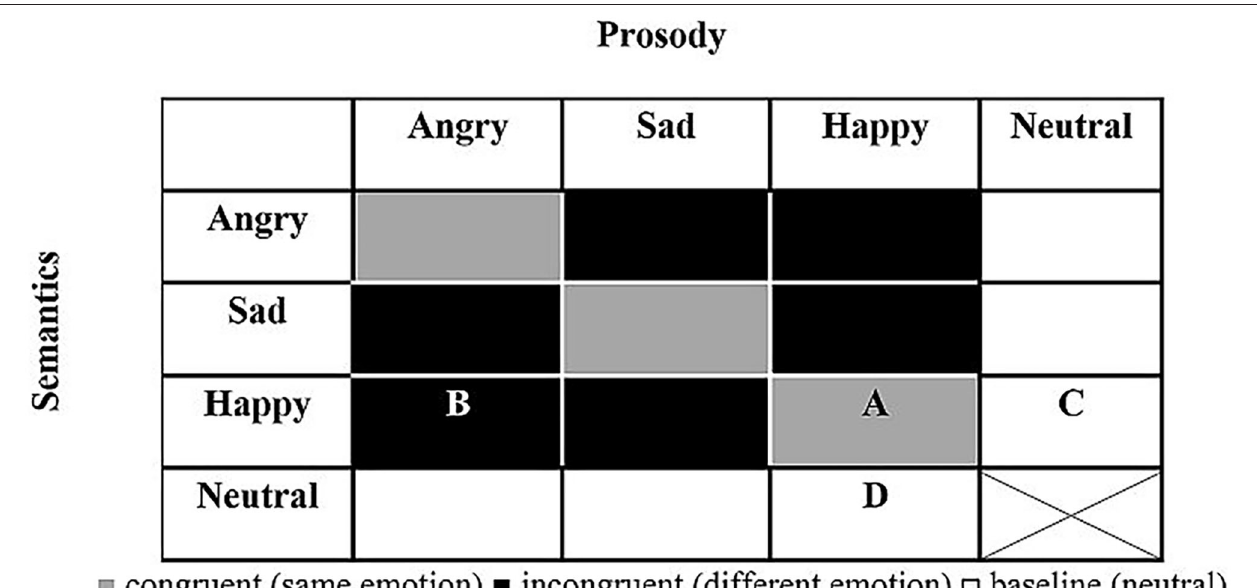
FIGURE 1 | General design of T-RES stimuli. All combinations of prosody and semantics (16) are presented in each emotional rating block (note: neutral semantics spoken with neutral prosody was deemed uninformative and confusing and was not presented). A, example of congruent stimulus (happy semantics and happy prosody); B, example of incongruent stimulus (happy semantics and angry prosody); C, example of baseline semantics (happy semantics and neutral prosody); D, example of baseline prosody (neutral semantics and happy